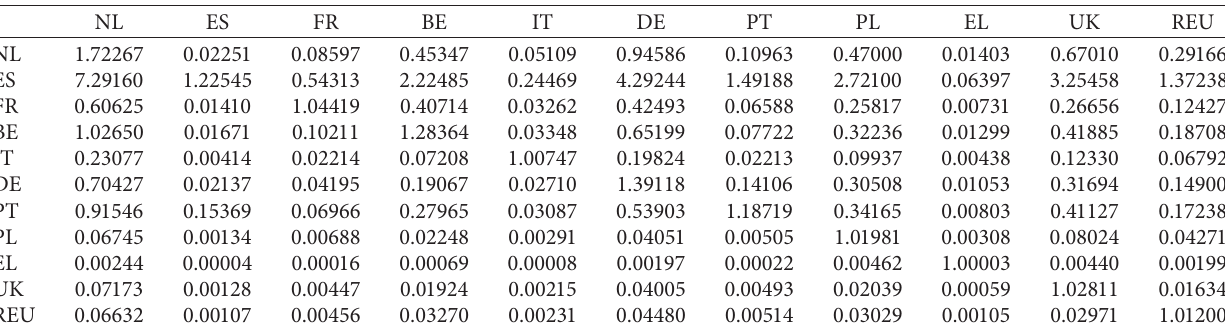
Table 8: Inverse matrix 2007.